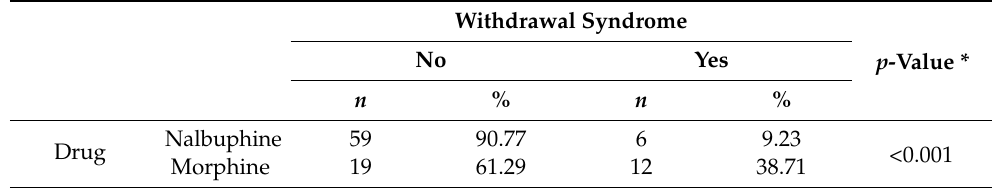
Table 6. Comparison of the incidence of withdrawal syndrome depending on the drug